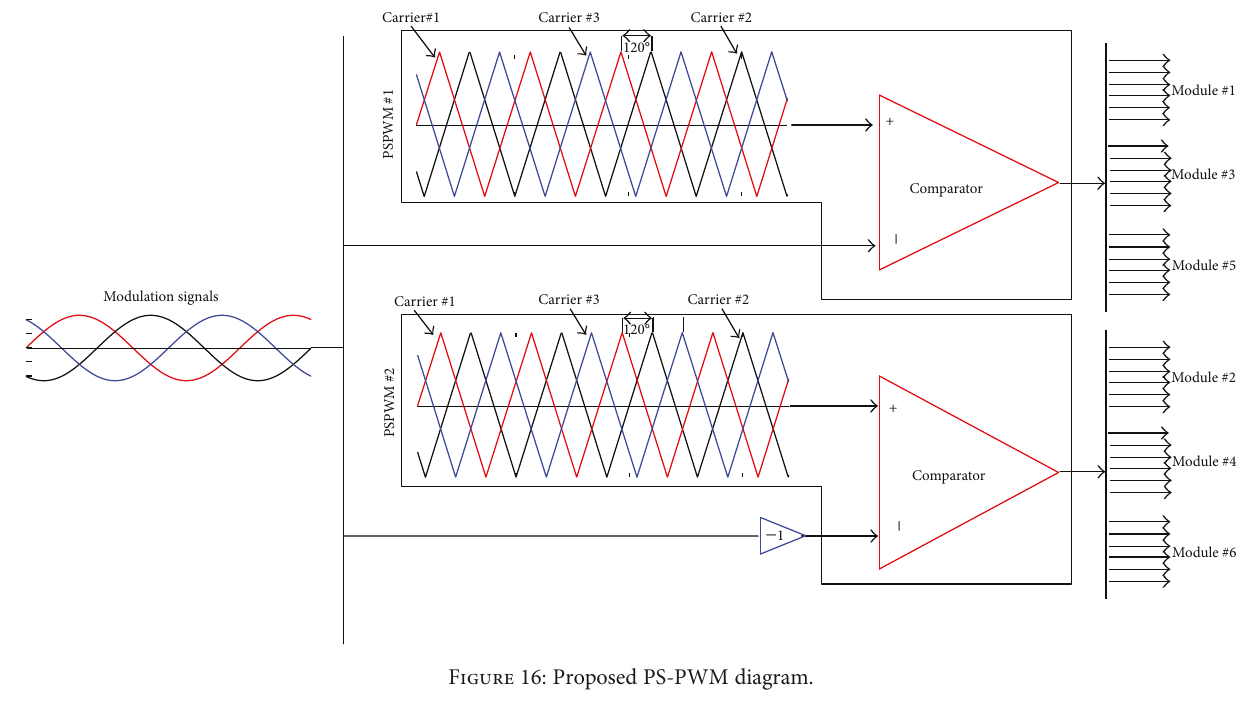
Figure 16: Proposed PS-PWM